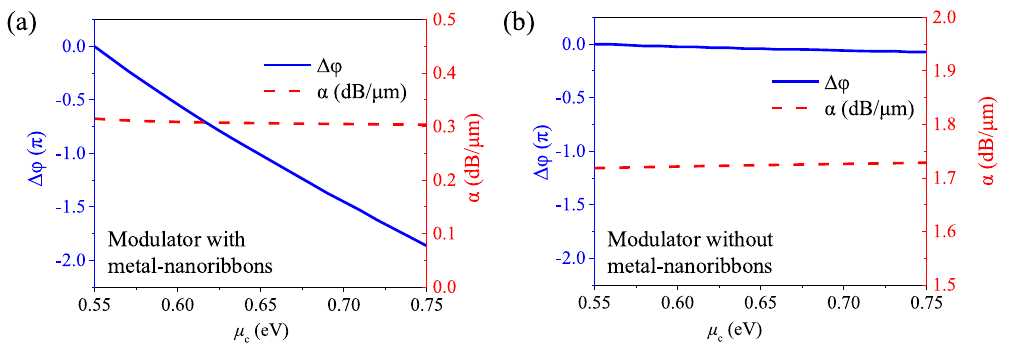
Figure 4: Phase change Δ φ and attenuation constant α for the 20 μ m length GPM under different chemical potential μ c ranging from 0.55 to 0.75 eV at 1.55 μ m (a) with the metal – nanoribbons. (b) Without the metal –